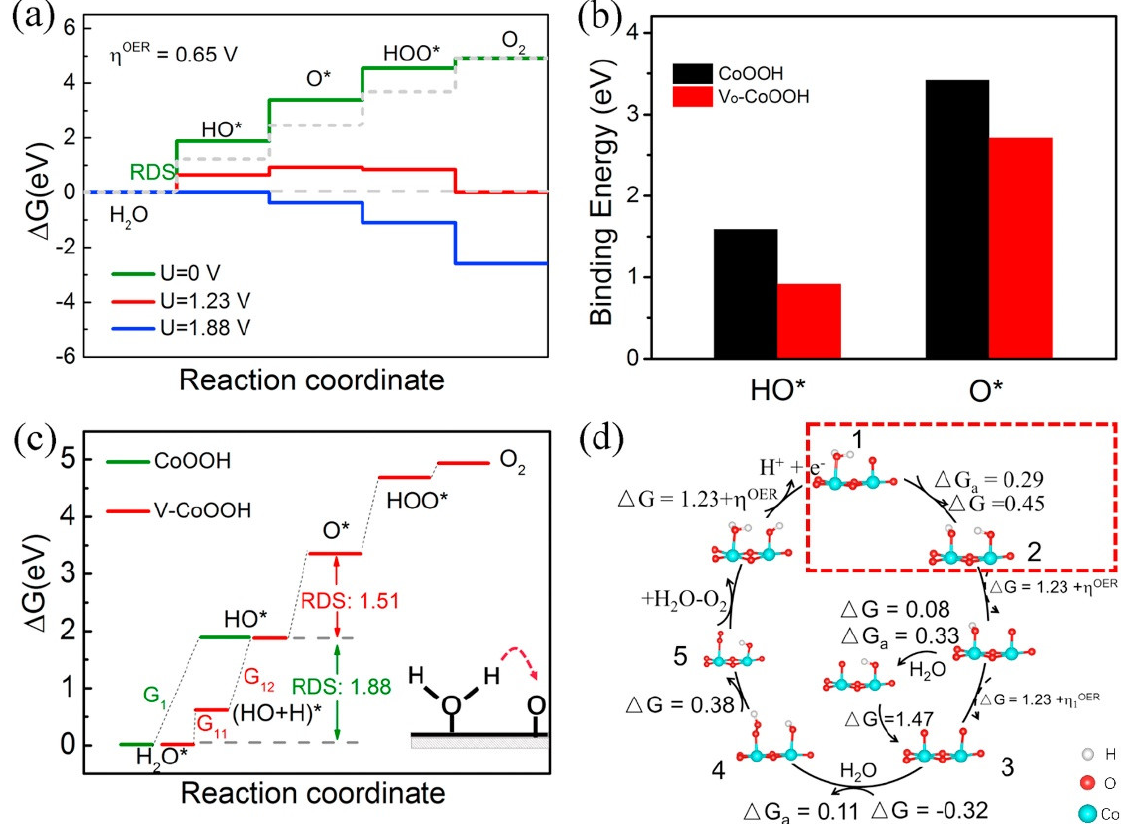
Figure 29. ( a ) Free energy diagram for the 4-step OER path under different positive potential U on pristine; ( b ) calculated binding energy for pristine and vacancy modified CoOOH; ( c ) Free energy diagram for 5-step OER path on oxygen vacancy modified CoOOH (011 ̅ 2) surface; and( d ) Schematic illustration of the OER pathways, the Gibbs free energy reduction (ΔG) and activation barriers (Δ G a ) of the evolution are given in eV. Cyan spheres-cobalt, red-oxygen, and white-hydrogen. (Reprinted from ref. [190] with permission from Nano Energy © 2017, Elsevier).